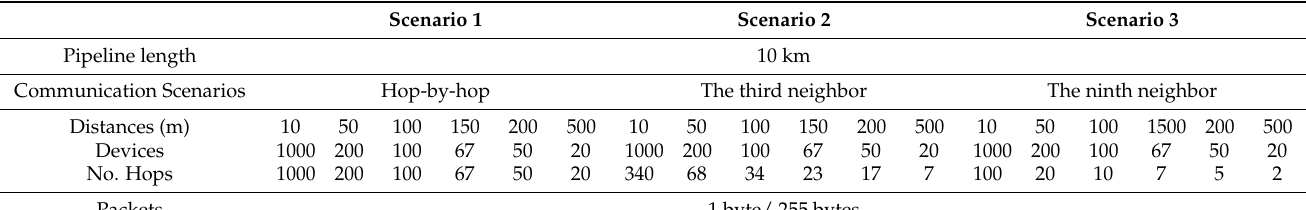
Table 4. Multi-Hop Communication Scenarios’ Parameters.